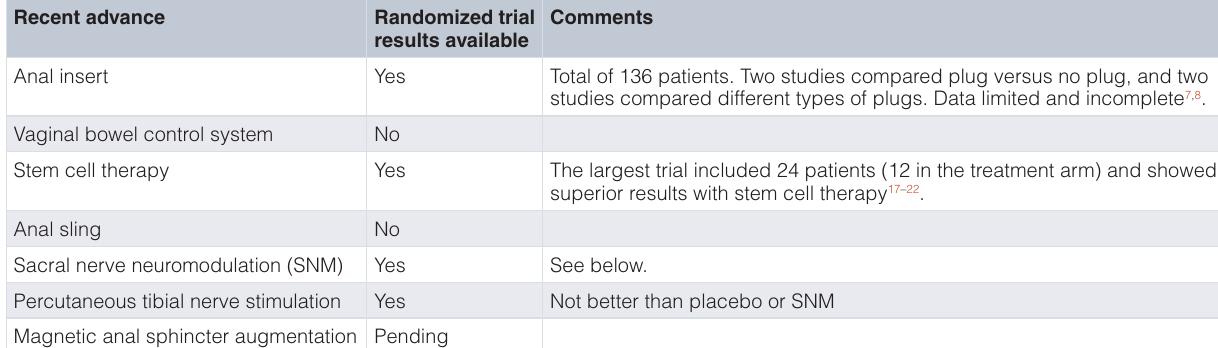
Table 2. Advancements in the treatment of fecal incontinence and the availability of published randomized trials. Recent